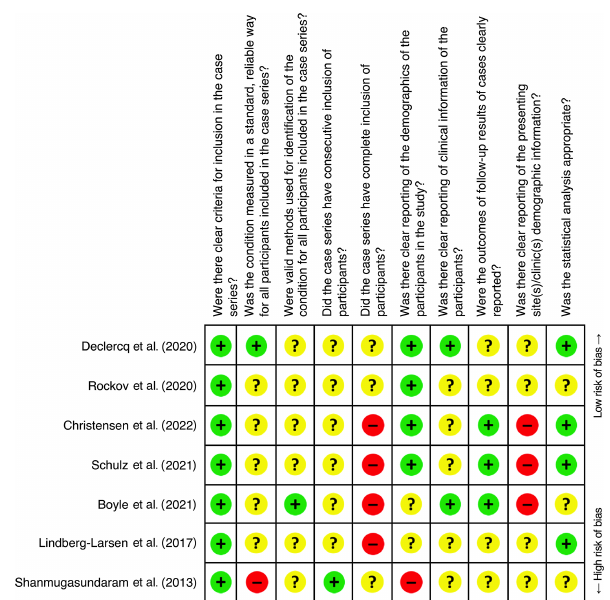
Figure 2. Risk of bias summary: review authors’ judgments about risk of bias items for each included study; – = high risk of bias; ? = unclear risk of bias; += low risk of